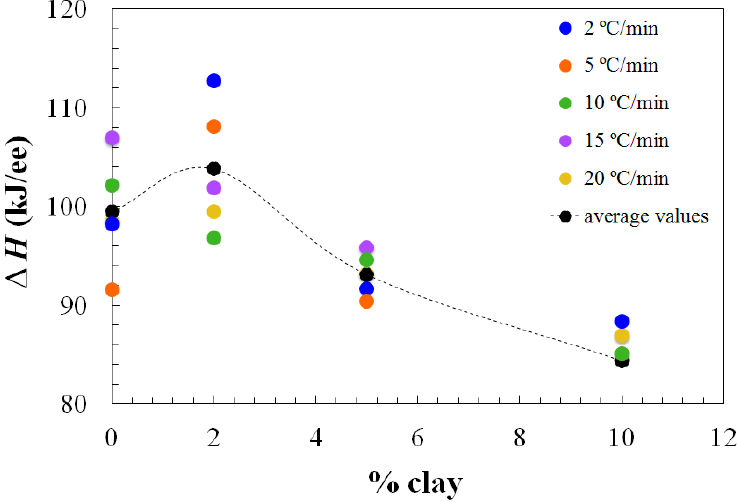
Figure 6. The dependence of the total heat of the reaction, ∆ H , on clay content for the non-isothermal cure. The dotted line represents the average value for each percent of clay